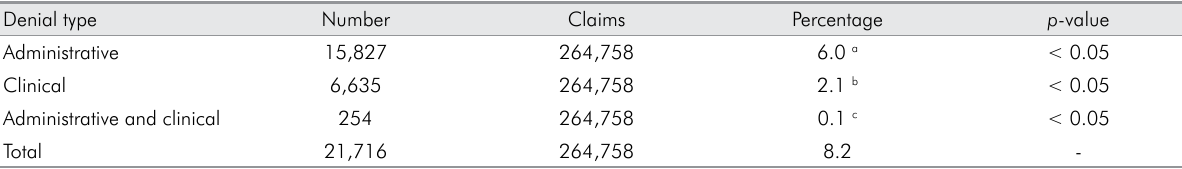
Table 2. Distribution of denial types in relation to the total number of claims.